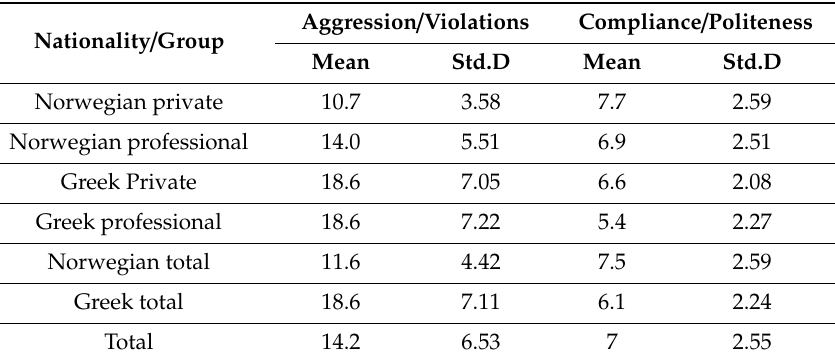
Table 8. National Road safety culture indexes.